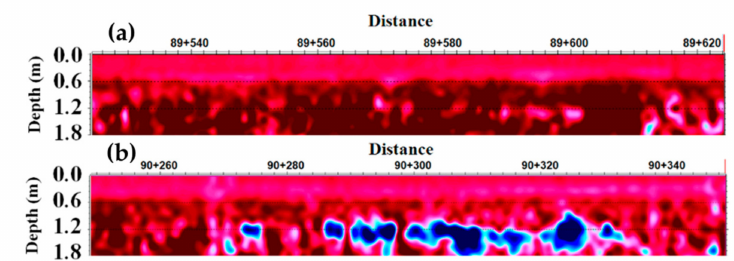
Figure 5. Moisture profiles: ( a ) low moisture; ( b ) high